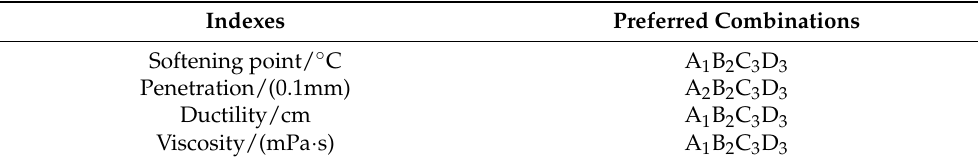
Table 5. Preferred combinations of orthogonal